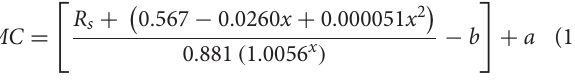
depths was used as a representative datum for correcting MC measurements taken at the same depths, but at other locations in the same panel. The thermistors were inserted from the North side of the panel into boreholes that were subsequently 8th,